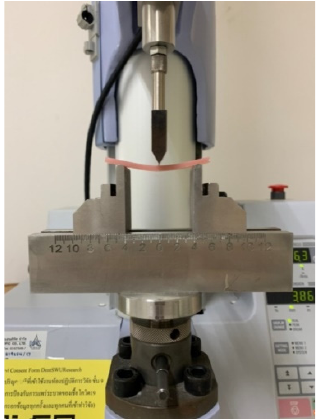
Figure 4. The testing machine and resin workpieces during the three-point flexure test.